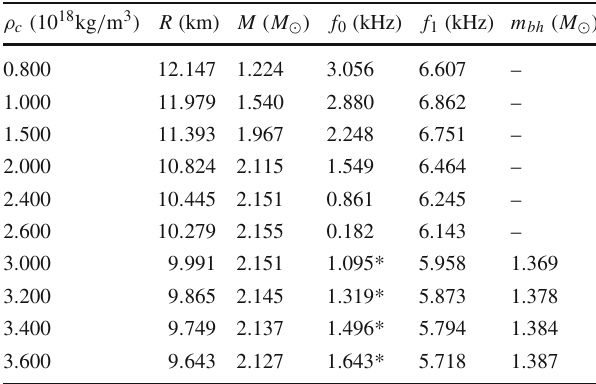
Table 4 Data for β BH = − 0 . 04 with SLy EoS in the radial pressure and anisotropy ansatz